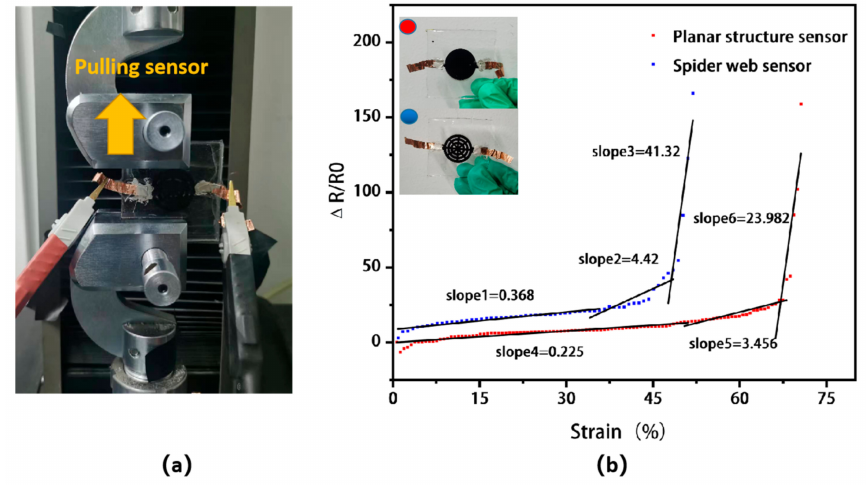
Figure 3. ( a ) Tensile test of spider web sensor and plane sensor; ( b ) Static tensile strain response of the spider web sensor and planar